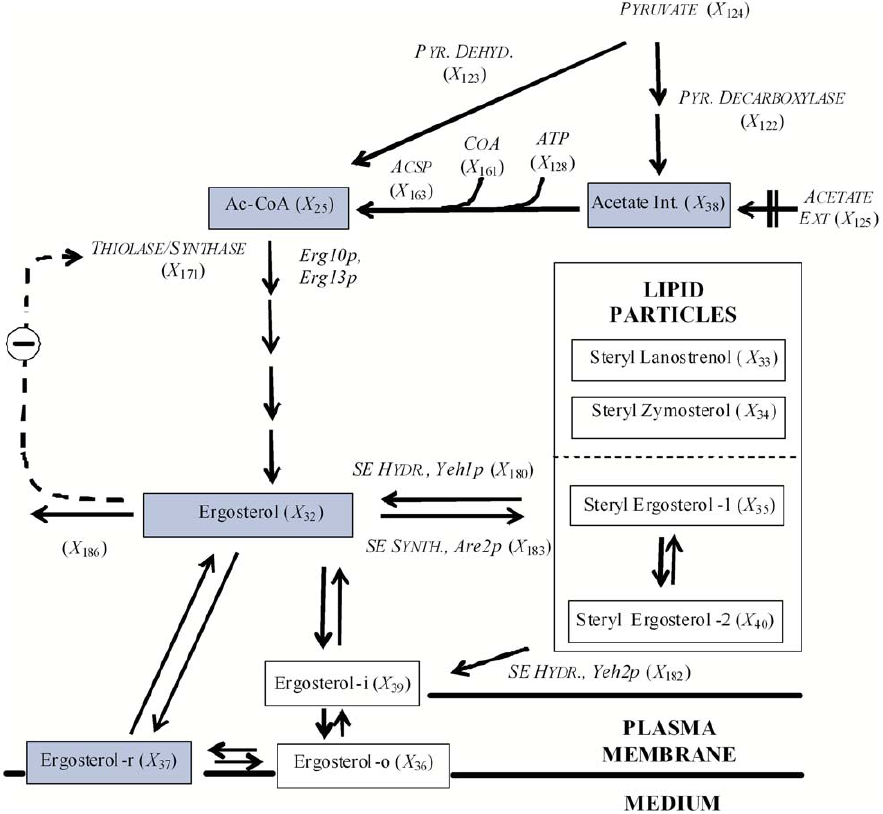
Figure 6. Yeast ergosterol diagram based on the highest sterol related SL-E logarithmic gains (metabolites) from Table S6. The diagram summarizes the ten time dependent metabolites of the ergosterol pathway associated with the highest sum of logarithmic gain magnitudes that are bigger than 1 (see Fig. 1 and Table S6). Solid boxes show time dependent variables and italics represent time independent variables. Consecutive arrows represent multiple enzymatic reactions, and the dashed arrow indicates a feedback signal. Blue boxes represent metabolites that also appear in the sphingolipid pathway (Fig. 2). Abbreviations for the time dependent variables: Acetyl-CoA (Ac-CoA), X 25 ; Endoplasmic reticulum ergosterol (Ergosterol), X 32 ; Steryl Lanosterol, X 33 ; Steryl Zymosterol, X 34 ; Steryl Ergosterol in Bulk Lipid Particles (Steryl Ergosterol-1), X 35 ; Outer Leaflet Ergosterol in the Plasma Membrane (Ergosterol-o), X 36 ; Detergent insoluble plasma associated ergosterol (Ergosterol-r), X 37 ; Internal Acetate (Acetate Int.), X 38 ; Inner Leaflet Ergosterol in the Plasma Membrane (Ergosterol-i), X 39 ; Steryl Ergosterol in Plasma Membrane Associated Lipid Particles (Steryl Ergosterol-2), X